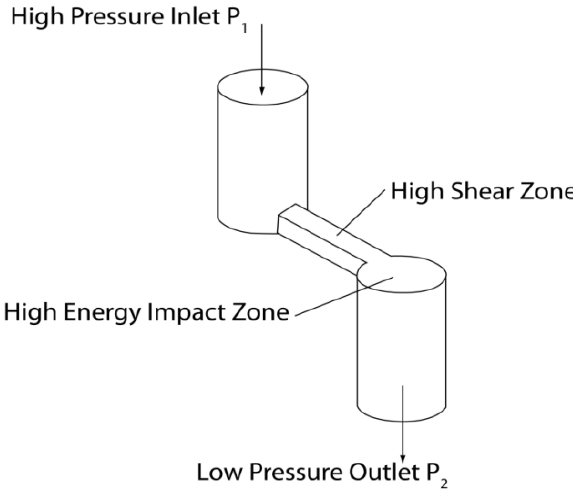
Figure 3. Z-type interaction chamber.